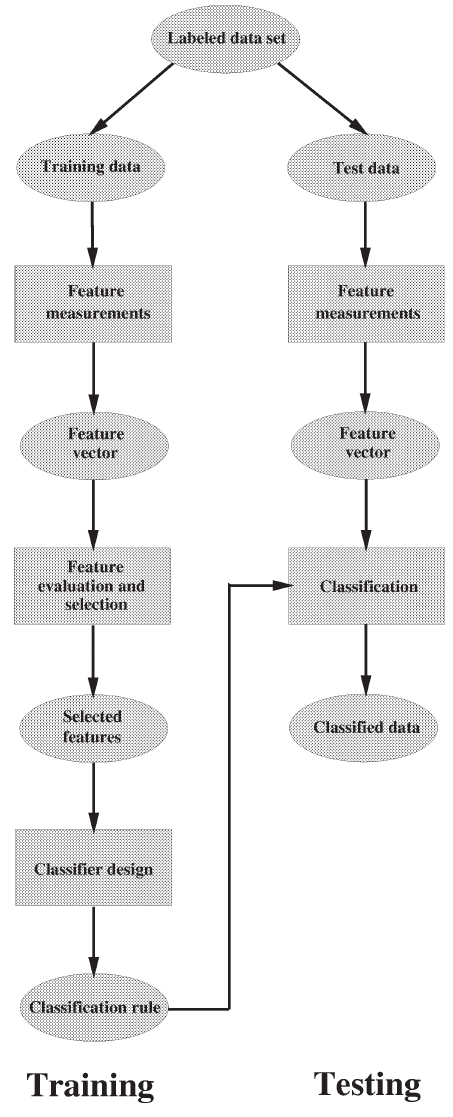
Fig. 1. Classification scheme with separate training and test